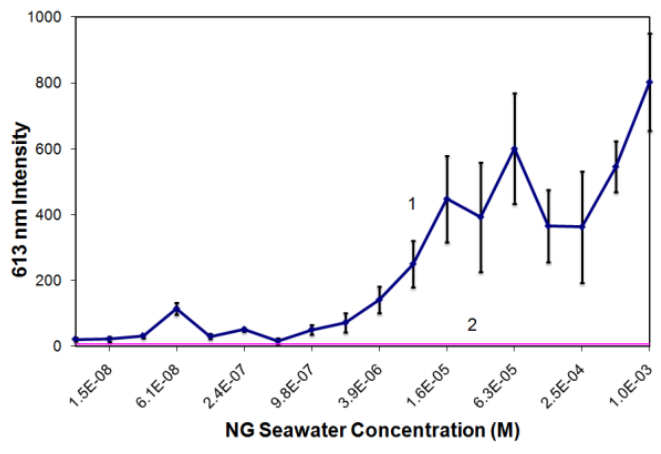
FIGURE 5 . Eu/TTA 613-nm emission (1) with varying amounts of NG and (2) without NG. The reagent solvent (methanol) comprised 5% of the solution.